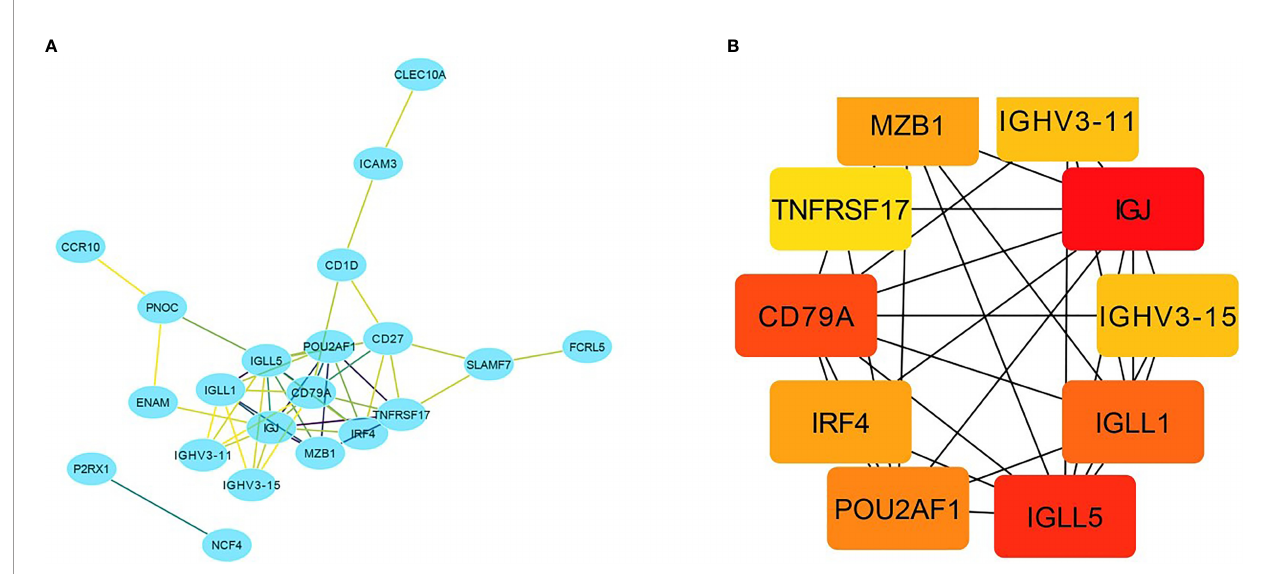
FIGURE 5 | Important gene module and hub gene screening. (A) Hub genes identi fi ed in the grey60 module; (B) Top 10 hub genes screened in the grey60